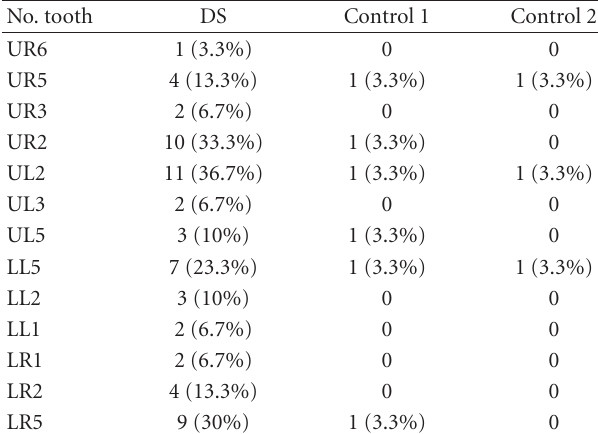
Table 4: Number and percentage of missing teeth by